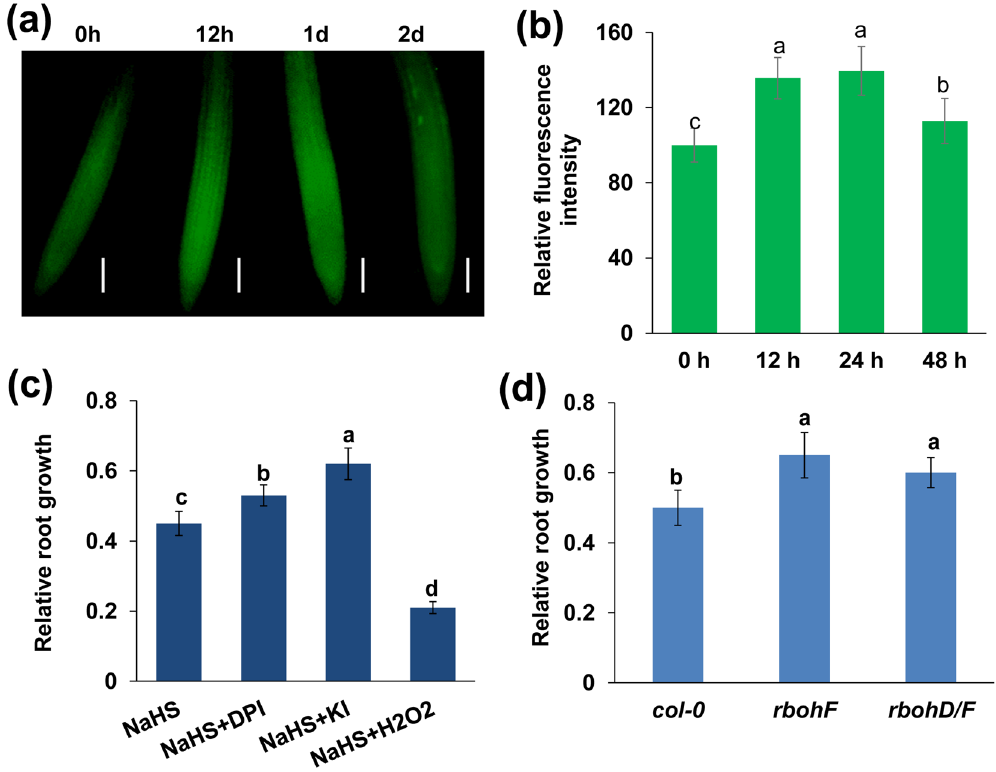
Figure 2. NaHS induces the accumulation of ROS. ( a , b ) Detection of ROS production in the roots of 5-d-old Col - 0 seedlings exposed to 500 μ M NaHS for periods of up to 2 d using the ROS-specific fluorescent probe DCFH-DA ( a ) and quantification of ROS-specific fluorescence intensities ( b ) in plants treated as described in ( a ). The fluorescence intensity of the untreated roots was set to 100. Bars, 100 μ m. n = 30. ( c ) Relative root growth of Col - 0 seedlings treated with 500 μ M NaHS in the presence or absence of 1 μ M DPI, 1 mM KI, and 1 mM H 2 O 2 for 2 d compared with untreated seedlings. ( d ) Relative root growth of col - 0 , rbohF , and rbohD / F seedlings treated with 500 μ M NaHS for 2 d compared with untreated seedlings. n = 45. Error bars represent ± SD. Different letters indicate significantly different values (P < 0.05 by Tukey’s